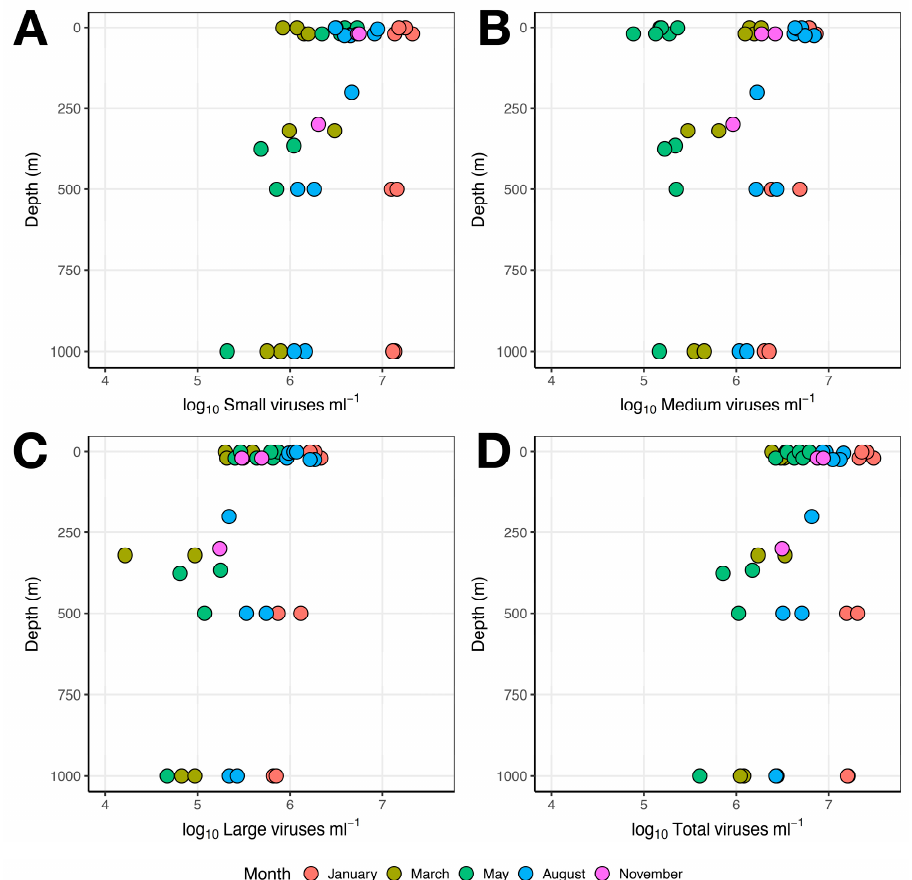
Figure 4. Scatterplot showing abundances of virus-like particles (VLPs) as determined by flow cytometric enumeration. ( A ) Small viruses, ( B ) medium viruses, ( C ) large viruses, ( D ) total viral abundance. Depth (m) is shown on the y axis. Sampling months are represented with different colors. Note logarithmic x